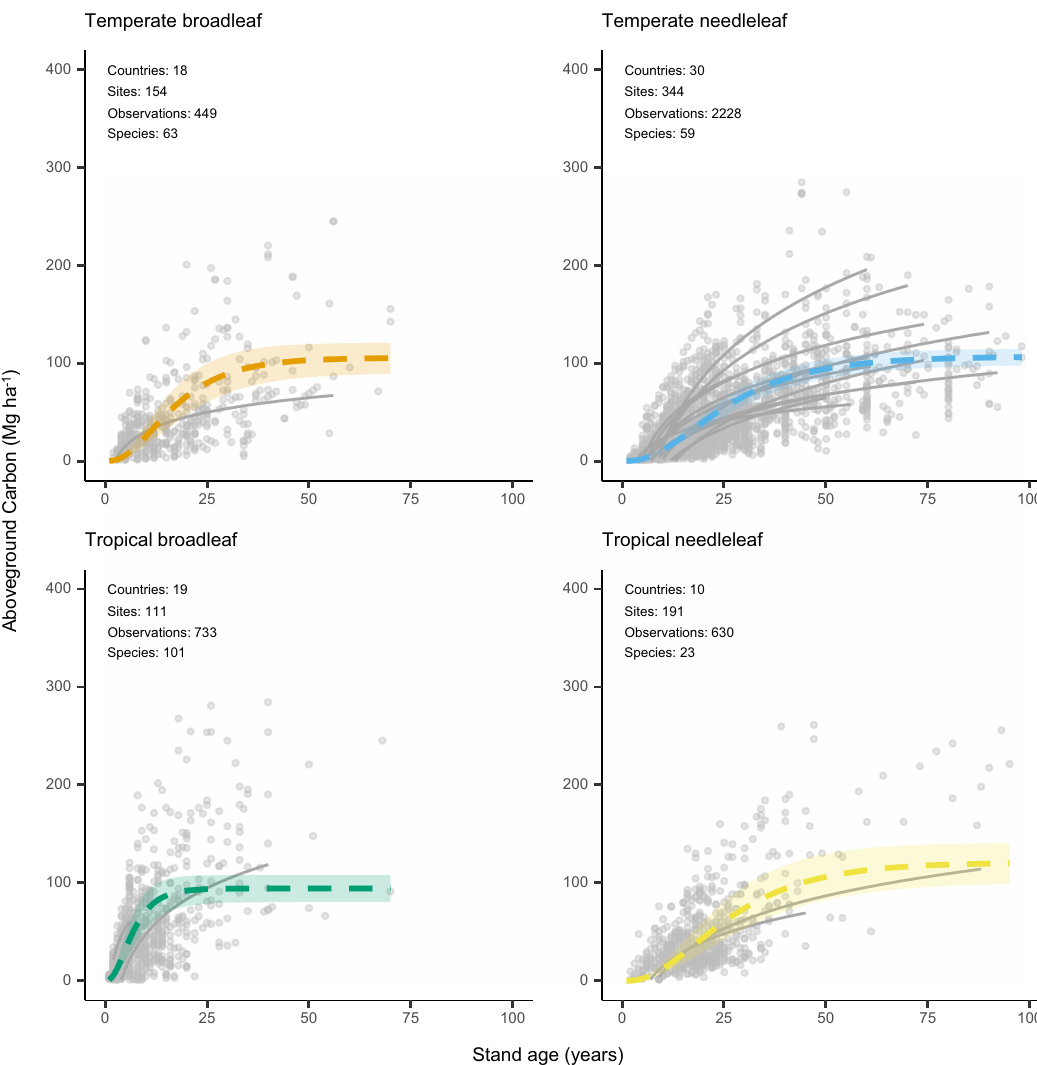
Fig. 3 Growth functions by plant functional type. Parameterized Chapman-Richards growth functions, with the shaded areas around curves denoting 95% con fi dence interval of predictions based on fi xed effects only. The grey curves (for visual comparison of species level trends) are logarithmic relationships between stand age and aboveground carbon for individual species with greater than 40 observations in the database. The growth function for the boreal needleleaf plant functional type is shown in Supplementary Fig.